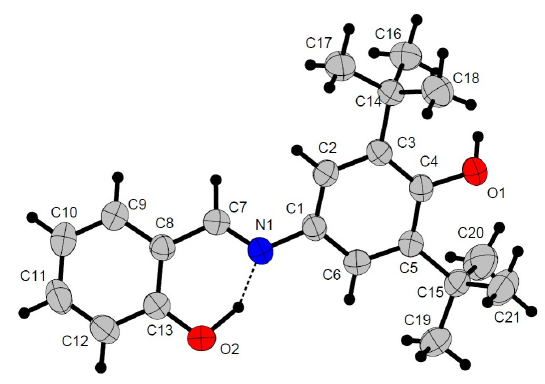
Figure 2. Molecular structure of starting compound L . Table 2. Selected bond distances (Å) and angles (°) for compounds L and 2 . Symmetry operation i = -x, 1-y, 1-z.